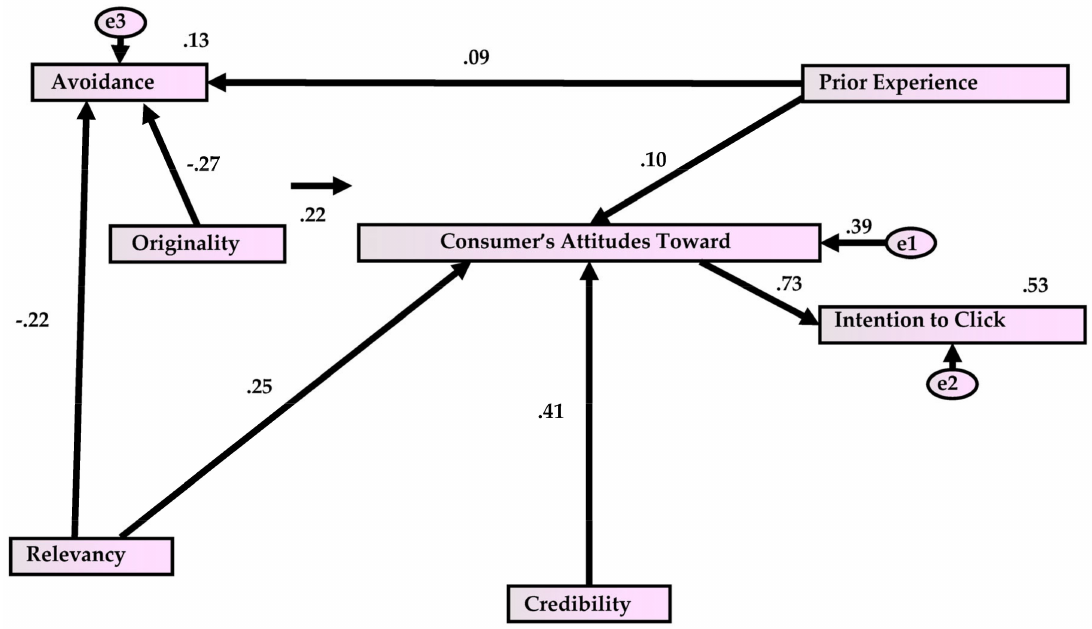
Figure 2. The study’s model